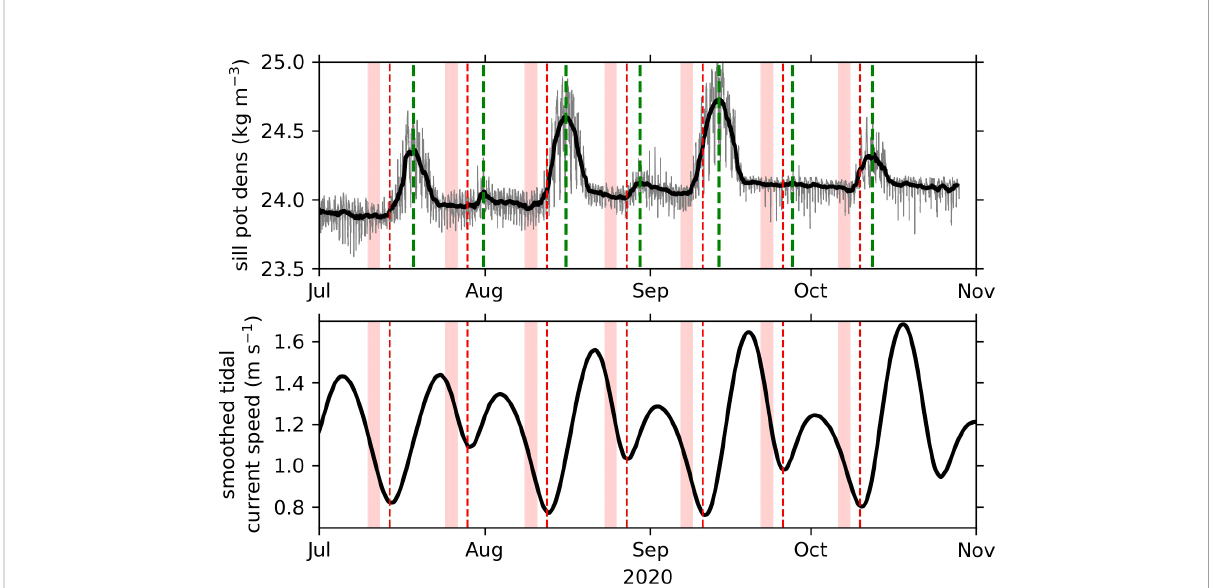
FIGURE 2 Relationship between potential density at the sill mooring and tidal current speeds for the 2020 renewal season. (upper panel) Potential density observed at the sill mooring ( s q , kg m -3 ). Thin gray line is the 10-min frequency data. Thick black line is smoothed with a 50-hr triangular fi lter. Vertical dashed green lines mark the times of the maximum smoothed density. (lower panel) Predicted absolute tidal current speeds at Active Pass smoothed with a 50-hr triangular fi lter (see Section 2.3). (both panels) Vertical red dashed lines mark the times of the minima in smoothed tidal current speed associated with an event. Lighter red bars indicate the pre-event window for calculation of the baseline potential